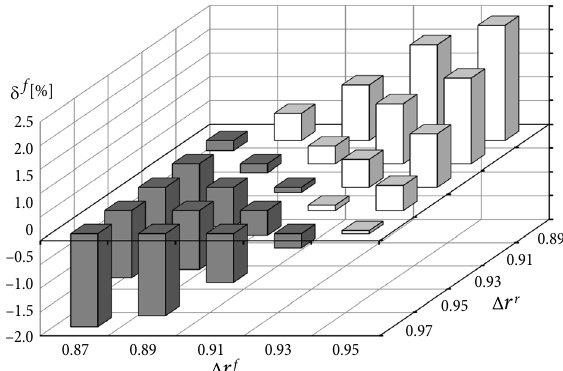
Fig. 6. Front wheel slippage/skid dependences on deformation values of front and rear tires